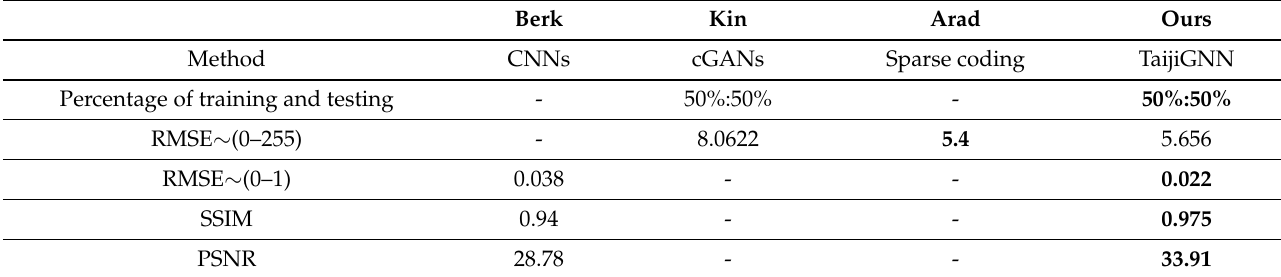
Table 6. The quantitative measurement of converting RGB image to multispectral image [15,20,21]. Berk Kin Arad Ours Method CNNs cGANs Sparse coding TaijiGNN Percentage of training and testing - 50%:50% - 50%:50%